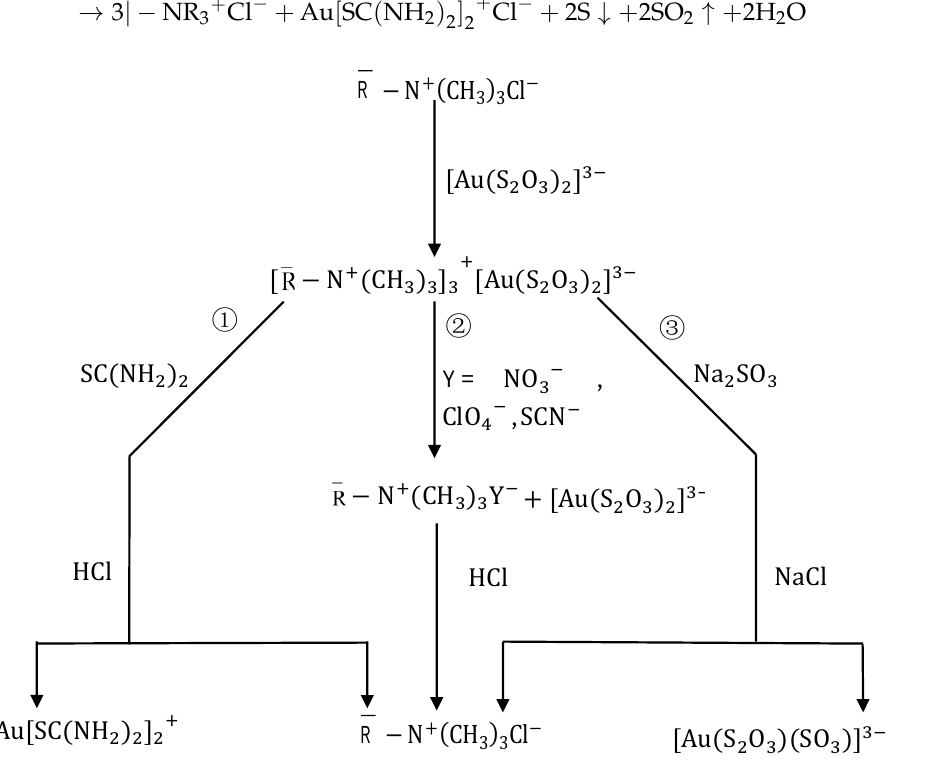
Figure 2. The elution of gold from strong-base resins ( ① , ② and ③ represent the elution procedure of [Au(S 2 O 3 ) 2 ] 3− anions loaded on the resin through the chemical reaction, displacement and synergistic ion exchange principles, respectively).